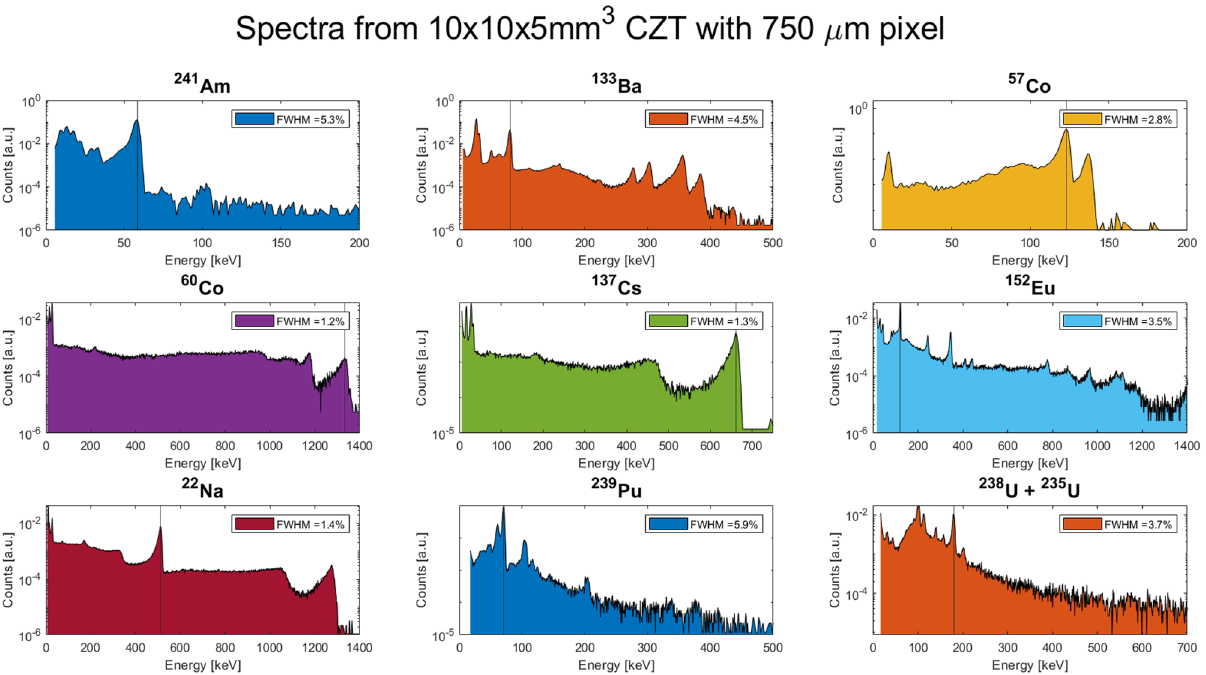
Figure 8. Spectra acquired with the best detector with a pixel of 750 µm, using nine different nuclear sources. The legend in the subplots reports the FWHM of the photopeak indicated by the vertical line. Measurements were carried out at 20